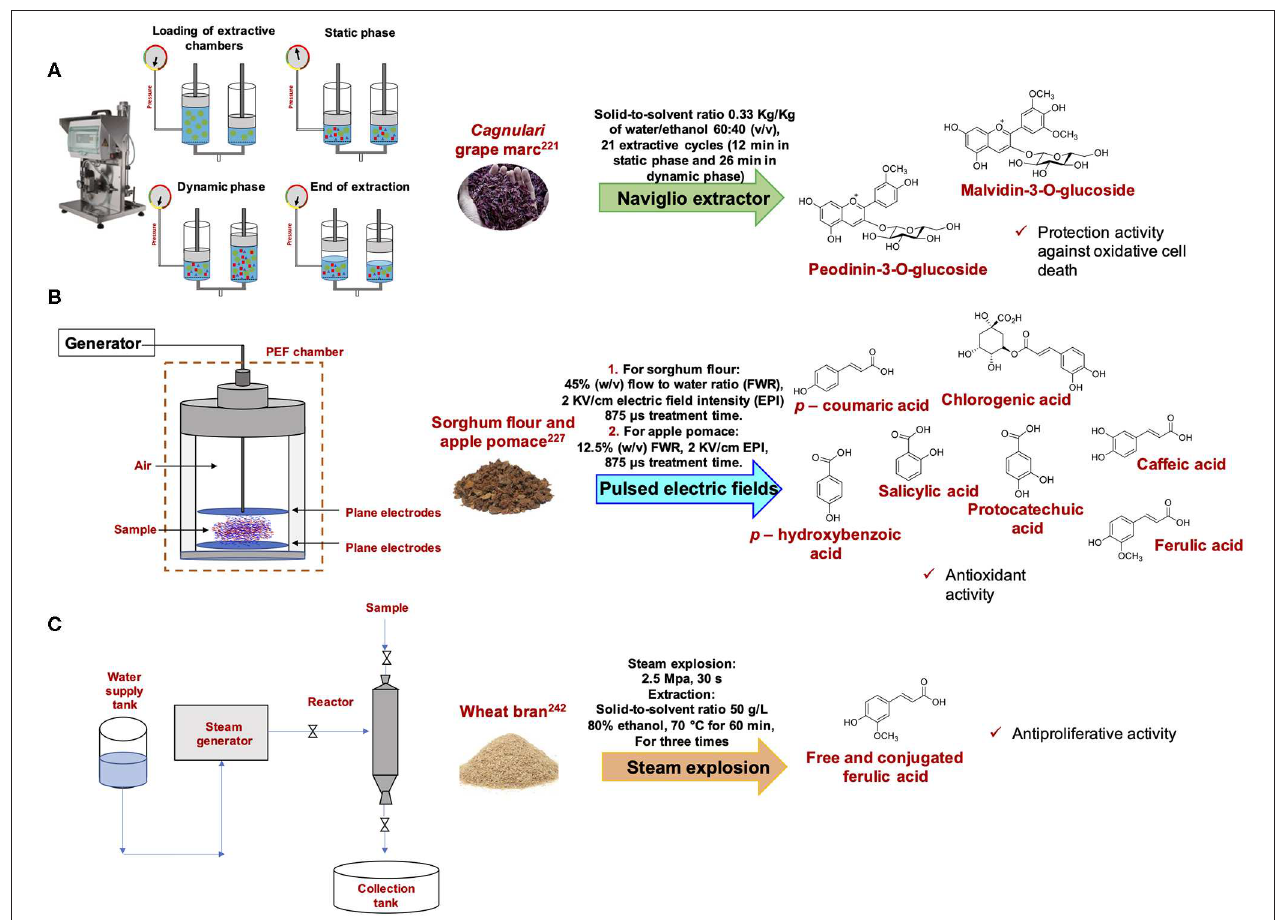
FIGURE 11 | Schematic representation and examples of extraction of bioactive compounds with (A) Naviglio Extractor ® , (B) PEF, and (C) steam